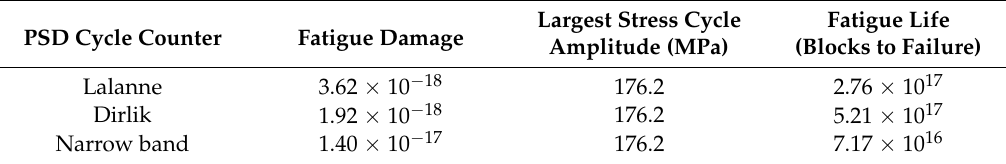
Table 7. Fatigue life using critical plane approach under highway road